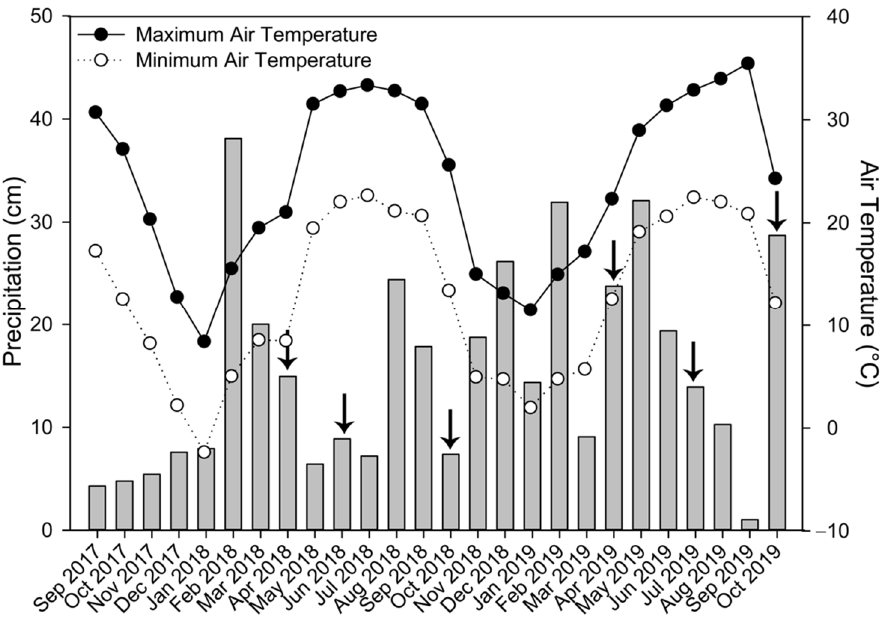
Figure 2. Monthly precipitation (bars) and average minimum (open circle) and maximum (closed circle) air temperature during the study period. Arrows indicate soil sample collection timepoints.